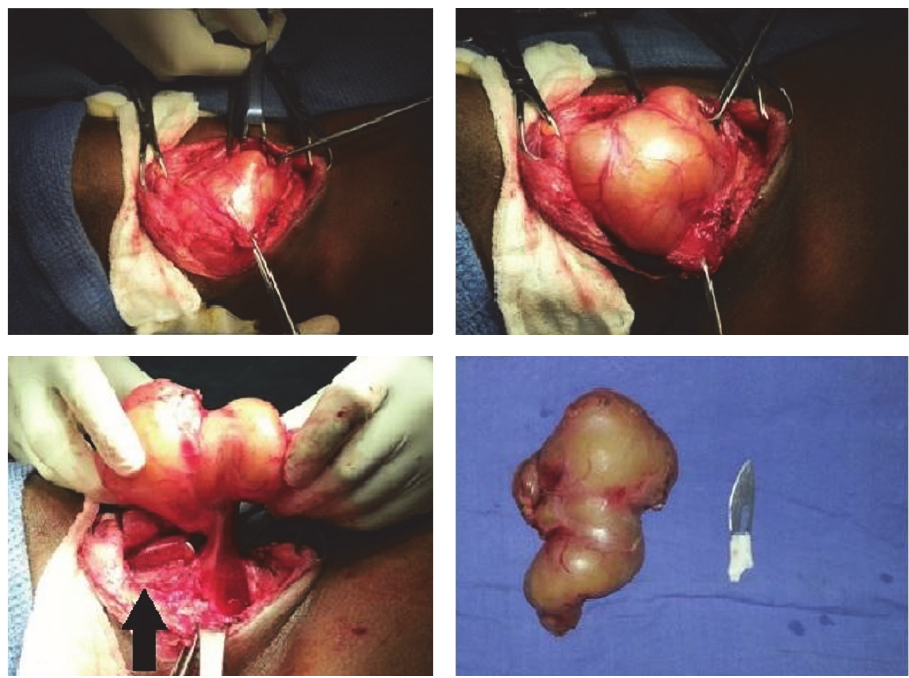
Figure 5: The first specimen seen related to vagus nerve (black arrow) and resected specimen measuring 12 × 7 cm.